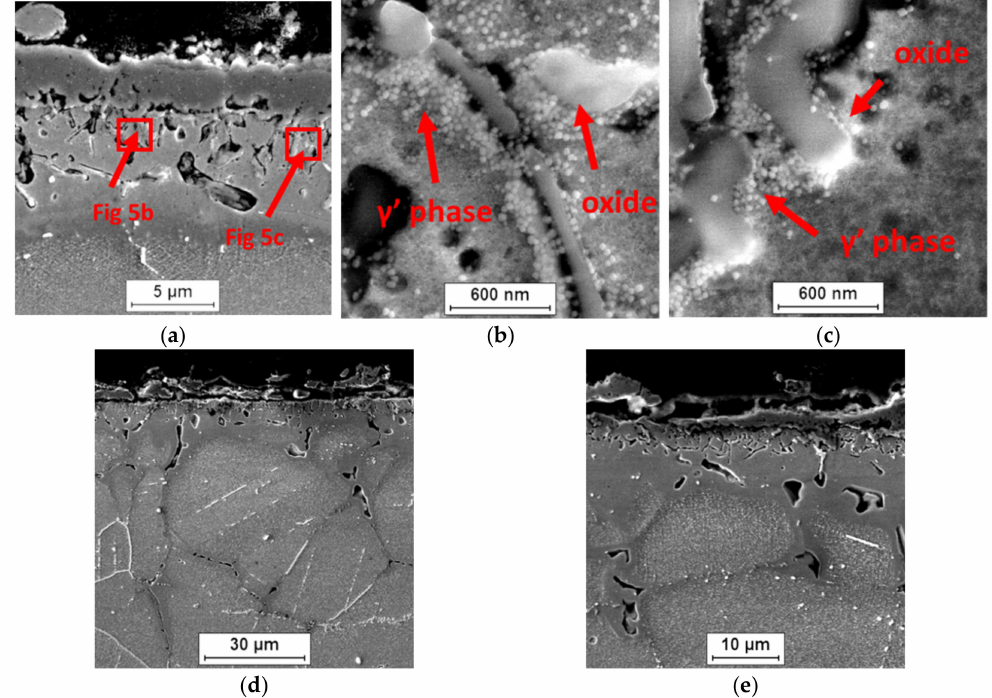
Figure 7. Influence of internal oxidation on changes in the surface layer of Inconel 740H alloy in a steam atmosphere at 750 ◦ C. SEM: ( a – c ) 500 h and ( d , e ) 2000